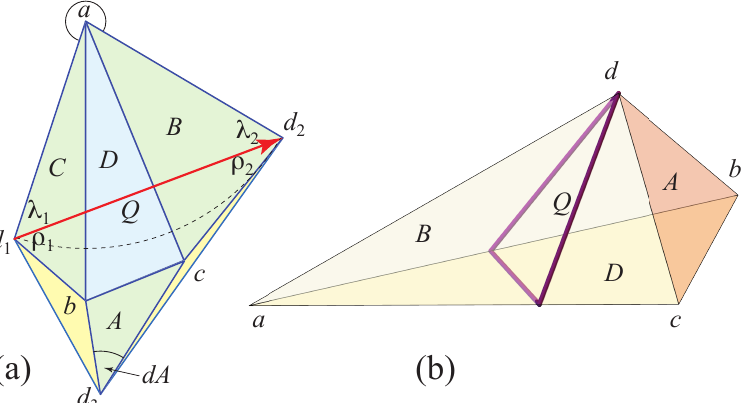
Figure 3. Case 1. ( a ) Unfolding of a tetrahedron when ω a > π and the other three curvatures are < π . d is closest to a . Curvatures at a , b , c , d are 282 ◦ ,140 ◦ ,173 ◦ ,124 ◦ . Auxiliary yellow triangles added. ( b ) The quasigeodesic in 3D.